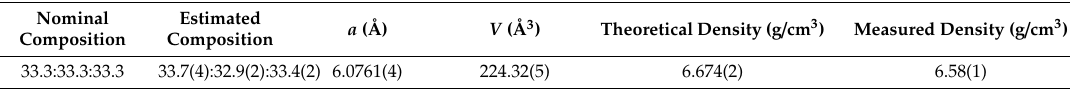
Table 1. Microstructural parameters determined for the studied sample of ScNiSb. Figure 1. X-ray diffraction pattern of the half-Heusler compound ScNiSb (Mo K α radiation). The solid line through the experimental points represents the refinement profile. Black ticks show the angular positions of the reflections of the ScNiSb phase. The asterisk marks a strongest reflection due to the Sc 2 O 3 phase. The difference pattern is shown as a black solid line on the bottom.